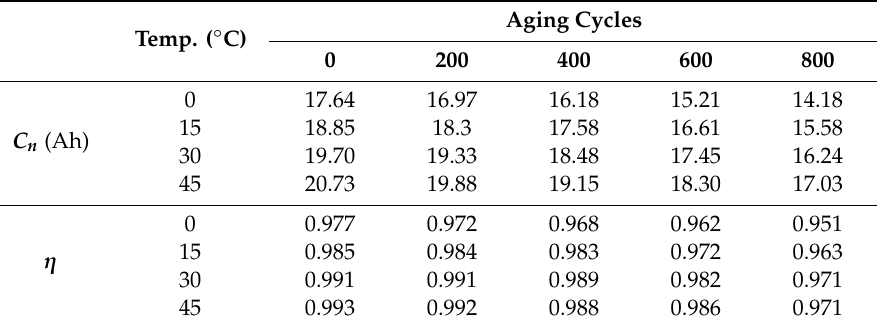
Table 1. Calibrated 𝐶 𝑛 and 𝜂 under different conditions.